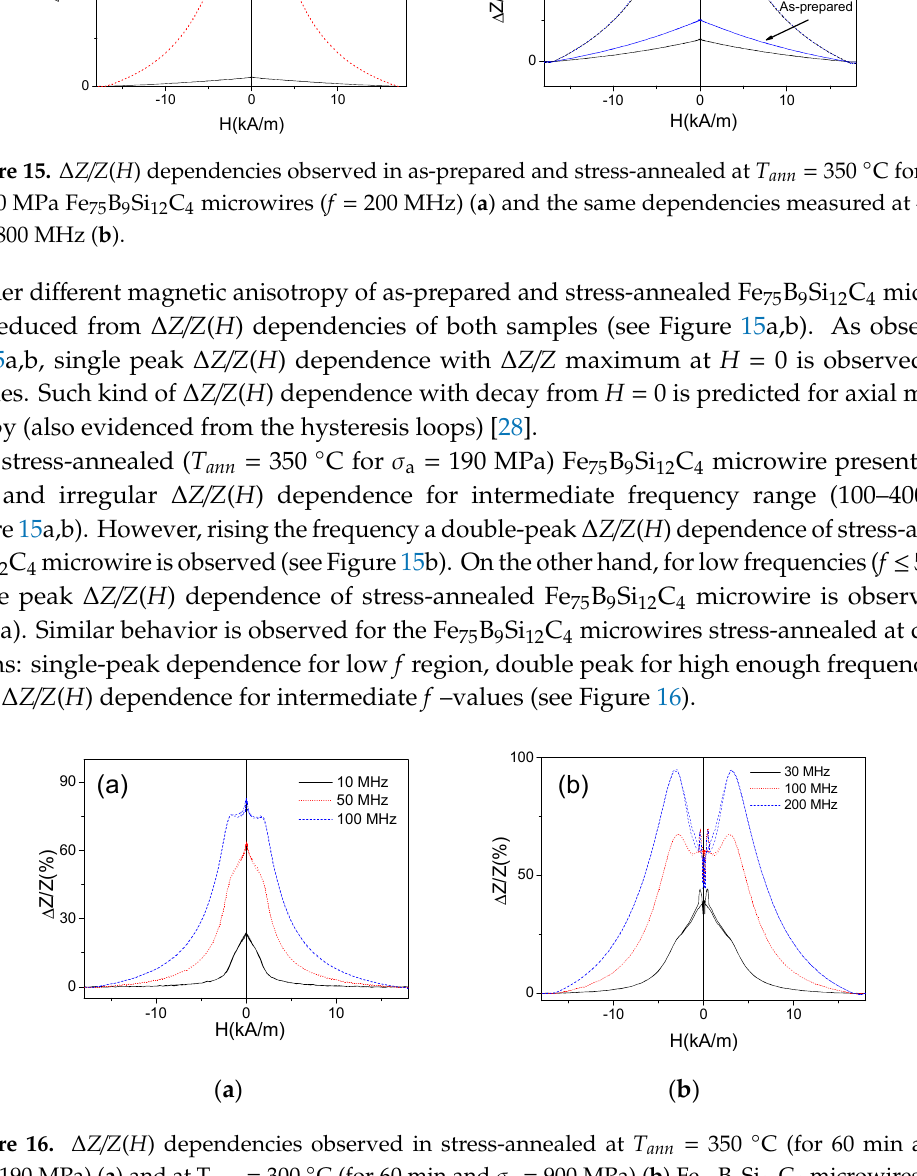
Figure 14. Effect of tensile stress applied during the annealing at 300 °C ( t ann = 60 min) ( a ) and annealing temperature at fixed σ a = 190 MPa; ( b ) on hysteresis loops of Fe 75 B 9 Si 12 C 4 microwire.